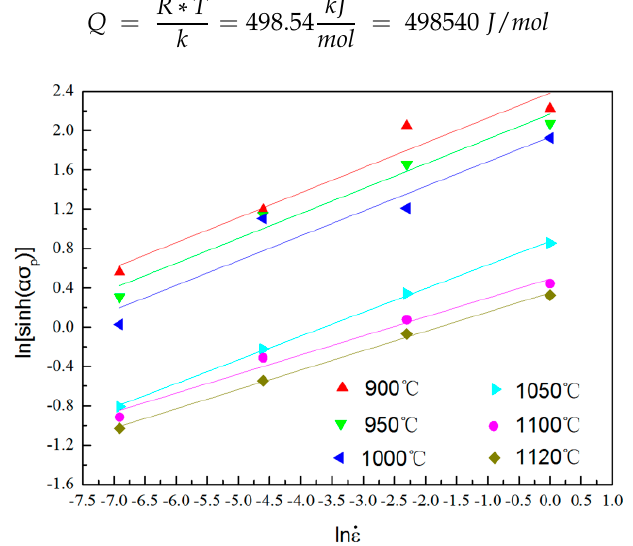
Metals 2019 , 9 , 1146